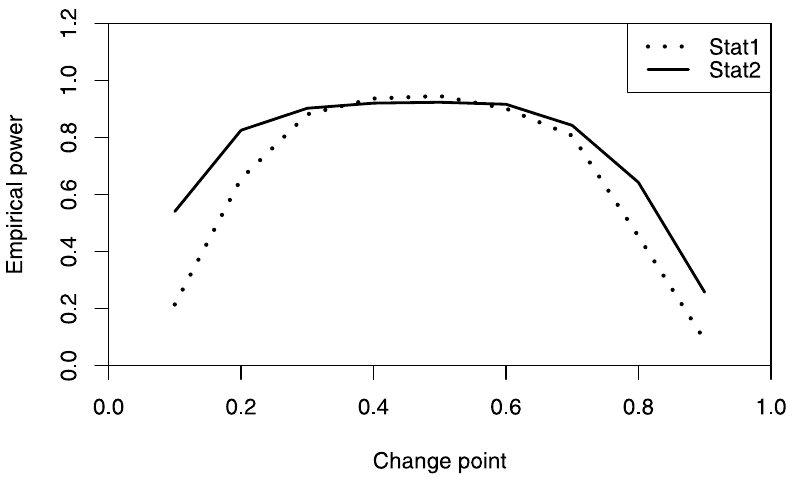
Fig 1. The empirical power of W 1 and W 2 under H ð 1 Þ